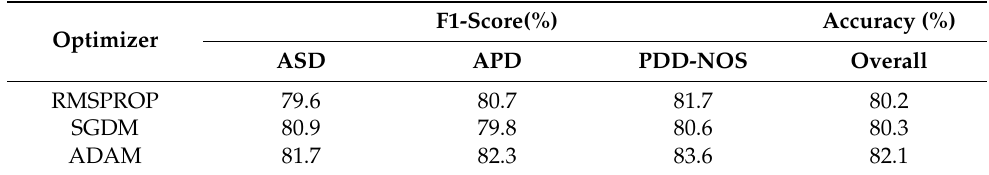
Table 7. Macro-accuracy (in %) of multi-class classification using three optimization